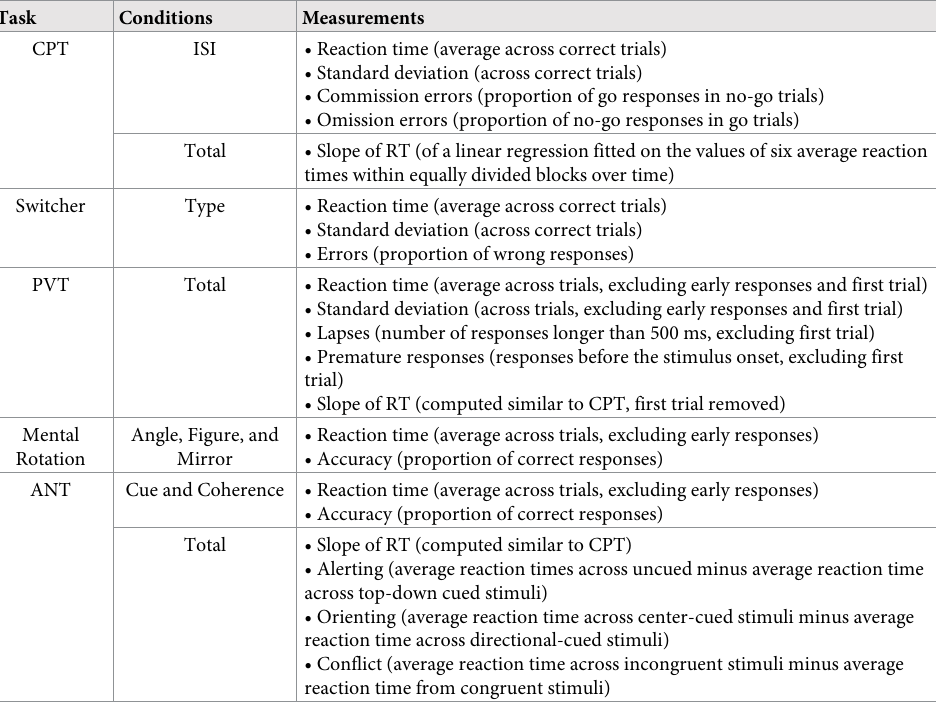
Table 2. Conditions of interest and measurements for each